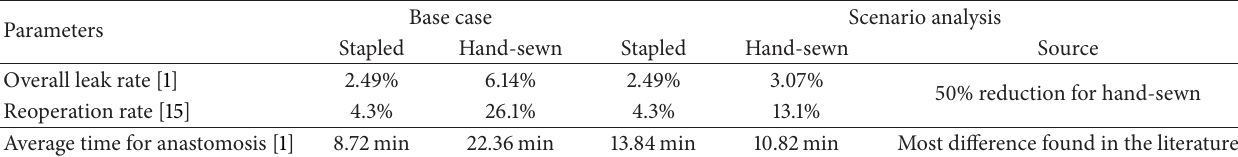
Table 5: Clinical inputs included in value analysis model.